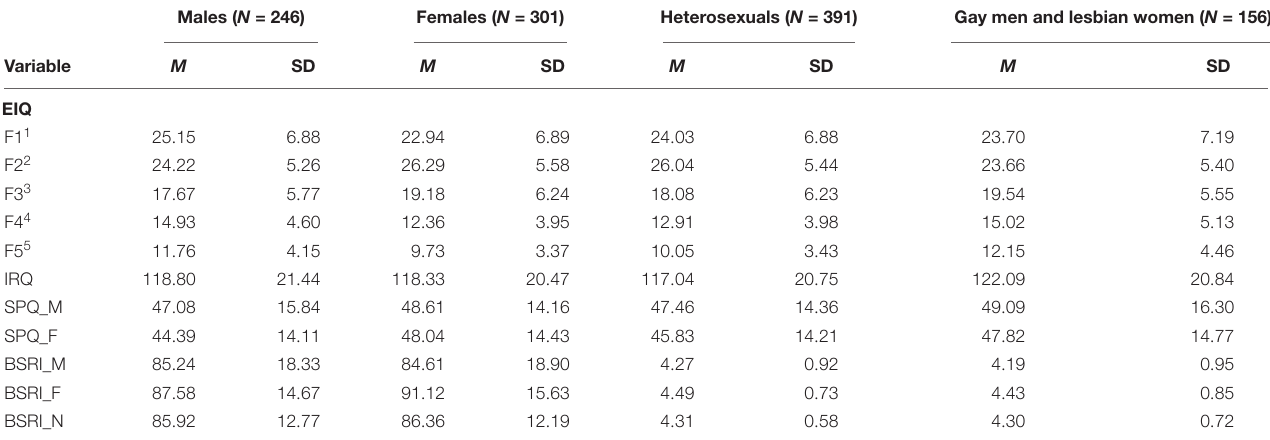
TABLE 2 | Means and standard deviations for the study variables, divided by gender and sexual orientation. Males ( N = 246) Females ( N = 301) Heterosexuals ( N = 391) Gay men and lesbian women ( N = 156)